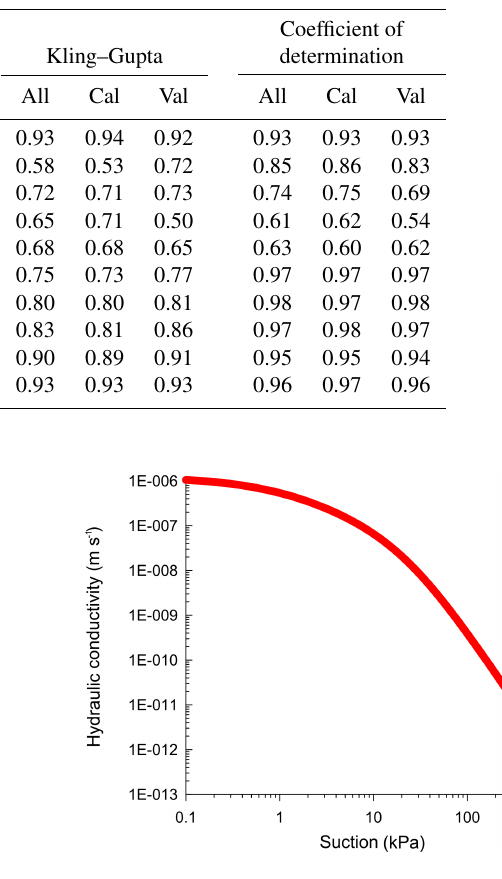
Table 2. Nash–Sutcliffe, Kling–Gupta and coefficient of determination assessed for proxy variables (WS, suction and temperature at different depths) considering all periods, only calibration periods (first and second hydrological year) and only validation periods (third and fourth hydrological year).